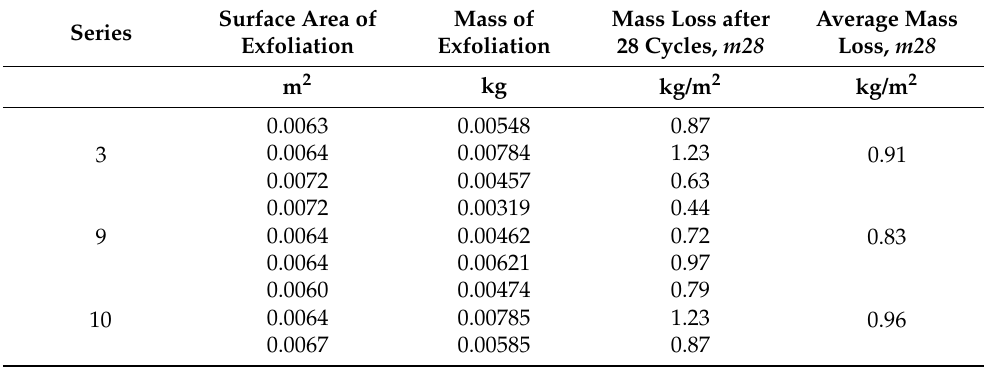
Table 9. Frost resistance results after 28 cycles of freezing and thawing.